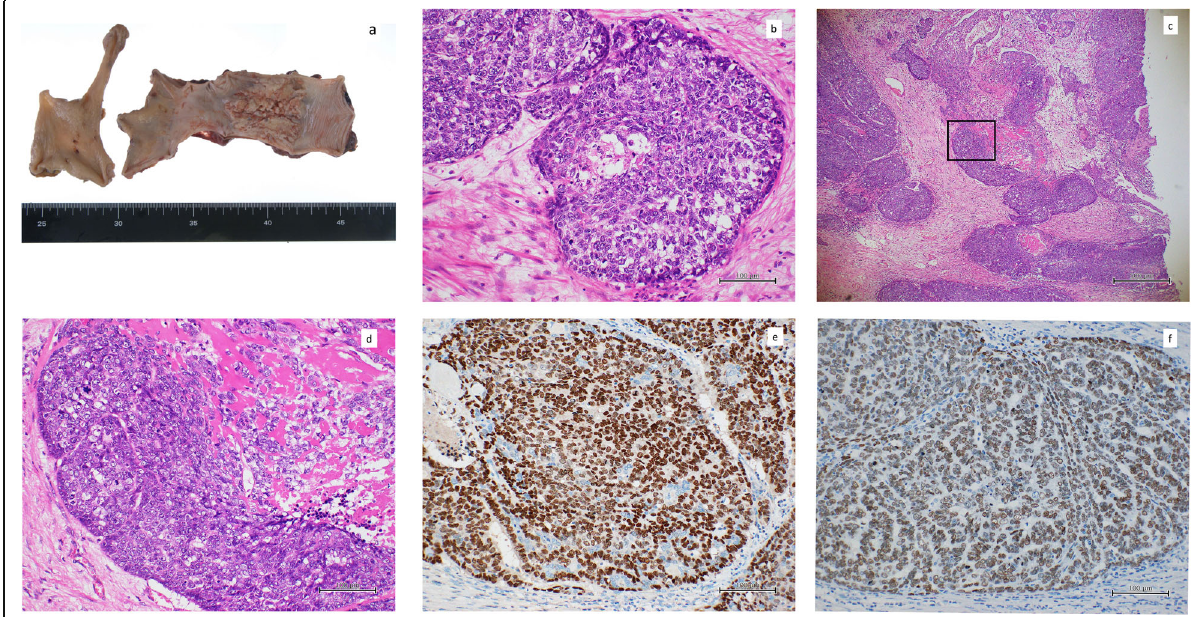
Fig. 1 a Macroscopic appearance of the opened esophagus and stomach shows an ulcerative and infiltrative type tumor in the middle thoracic esophagus. Histopathologic examination of the resected specimen shows moderately differentiated squamous cell carcinoma ( b hematoxylin and eosin stain, ×100), with a focal basaloid component (square, c × 4 and d × 100). Immunohistochemical examinations show that the primary tumor cells are positive for e p63and f p40 (×